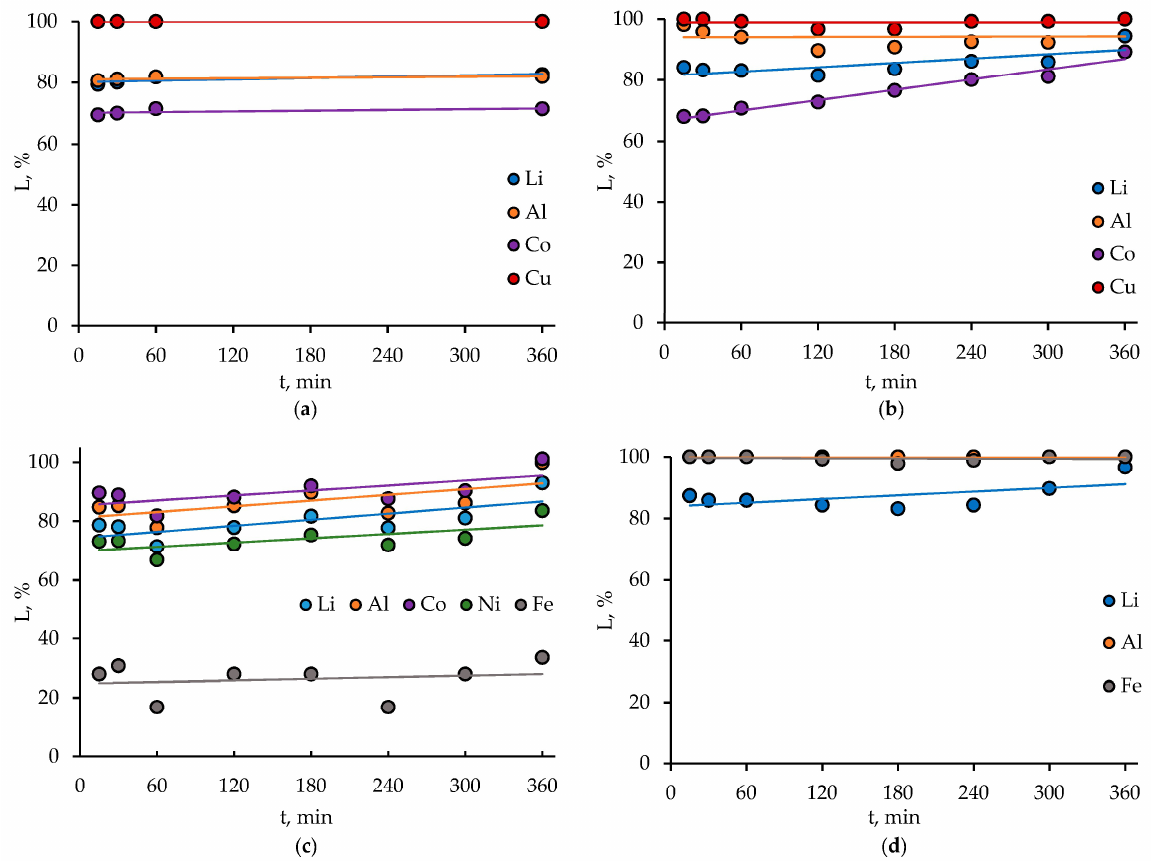
Figure 2. Effect of temperature and time on the metal leaching degree, C HCl = 2 M: ( a ) LIB 1, 25 °C, ( b ) LIB 1, 80 °C, ( c ) LIB 2, 80 °C, ( d ) LIB 3, 80 °C.